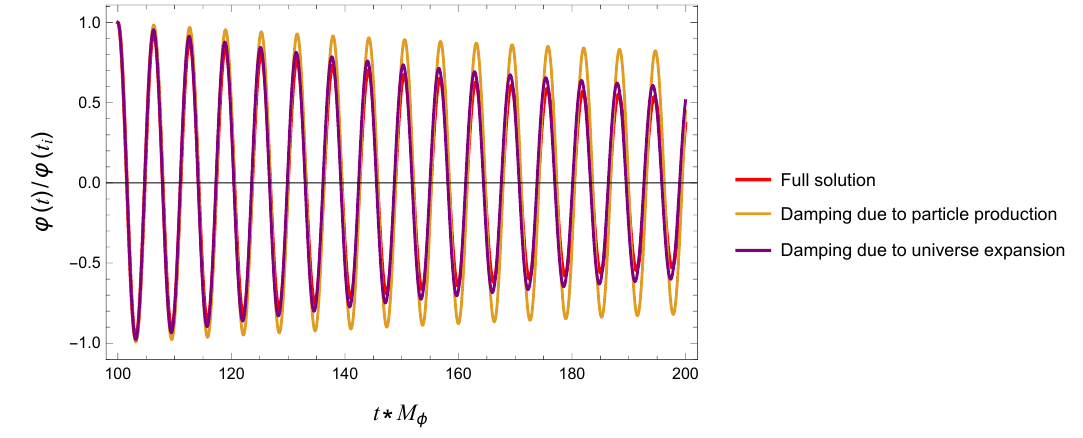
Figure 3 . Solutions of the condensate equation (2.24) with the imaginary part of the self-energy neglected ( γ = 0 ). Analytic approximation in a radiation-dominated universe, i.e., eqs. (3.45), is drawn in the red line with α = − 0 . 01 /M φ , σ = 0 . 005 /M φ , µ = 0 . 001 M φ , and λ φ = 0 . 05 . Analytic approximation in a static universe with the same parameters, given by eqs. (3.38), is drawn in the brown line. Analytic approximation without interactions in a radiation-dominated universe, i.e., eq. (3.40), is drawn in the purple